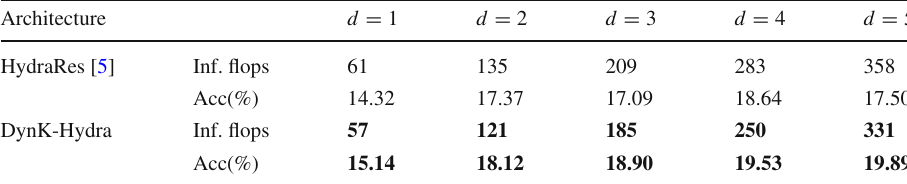
Table 3 Comparison of HydraRes and DynK-Hydra on ImageNet32 data set, in terms of both accuracy and inference